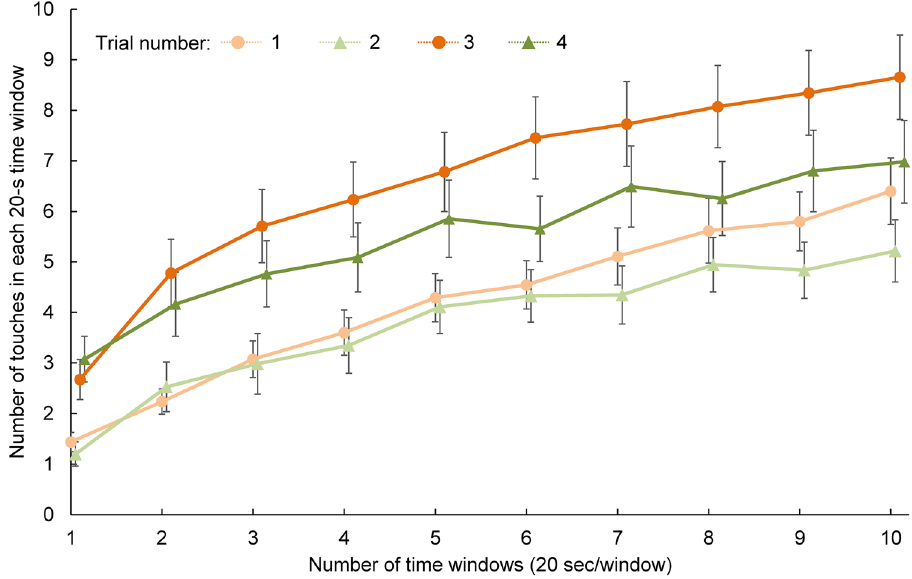
Figure 3. Motor control performance in the reaching task. Error bars represent standard errors.